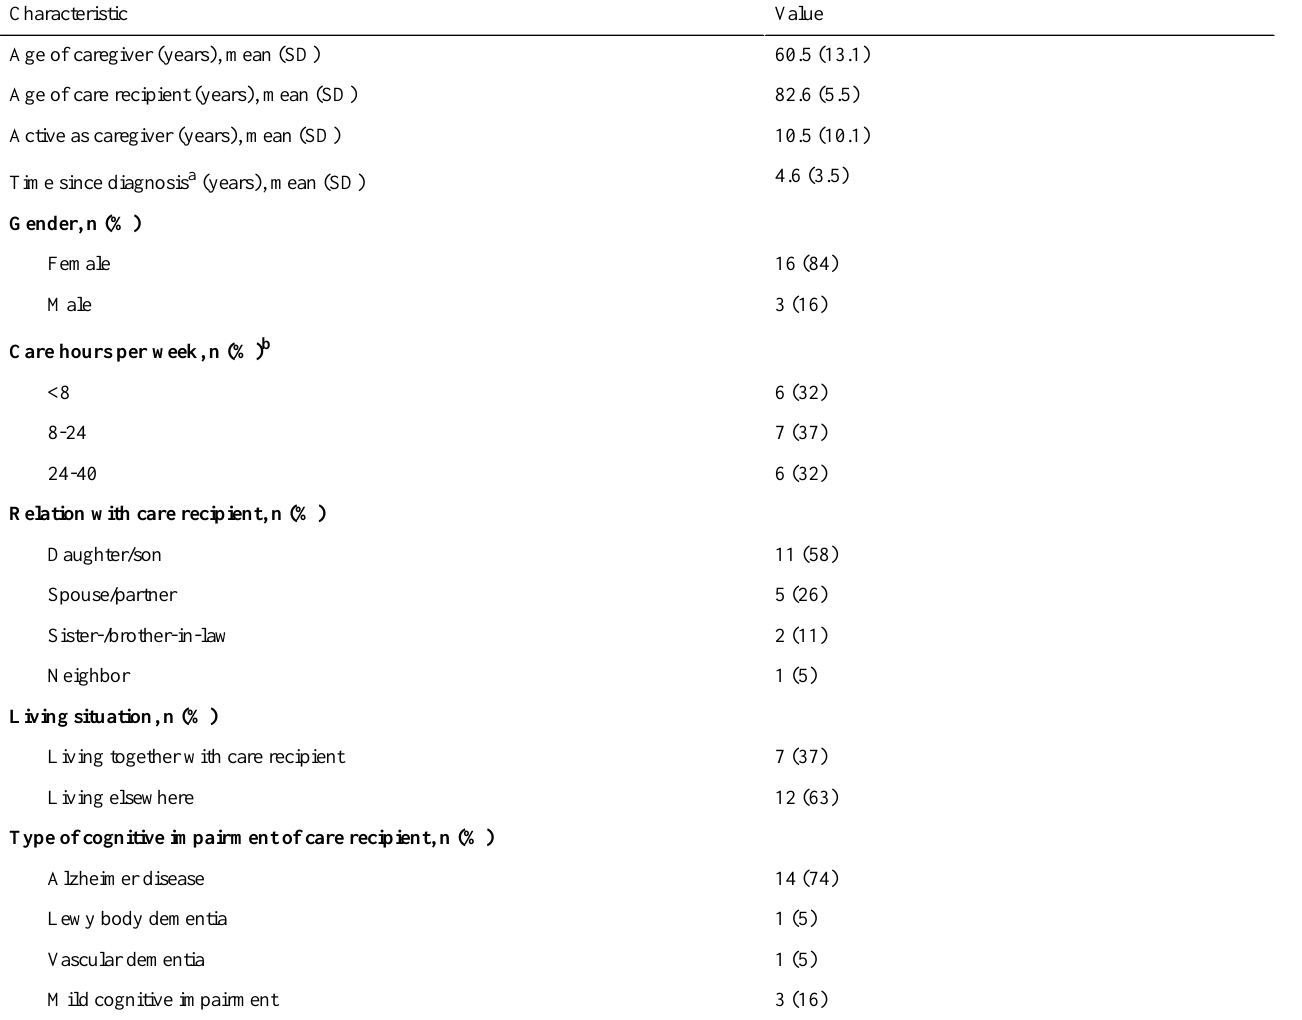
Table 1. Characteristics of informal caregivers (N=19).